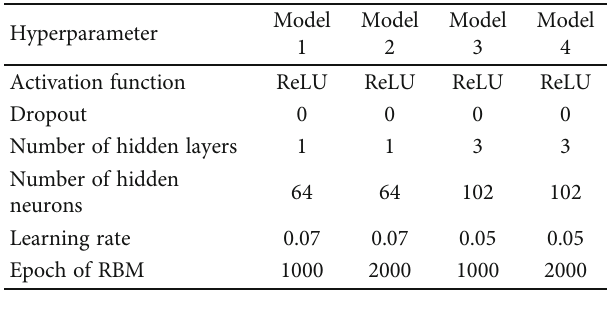
Figure 7: Deep neural network architecture. Table 3: List of optimization parameters for neural network